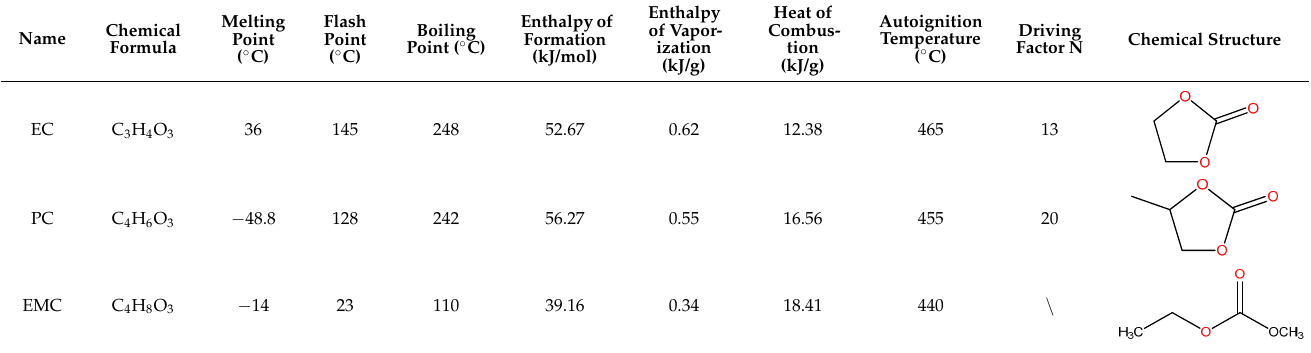
Table 1. Carbonate solvents used for thermal safety study in this paper.